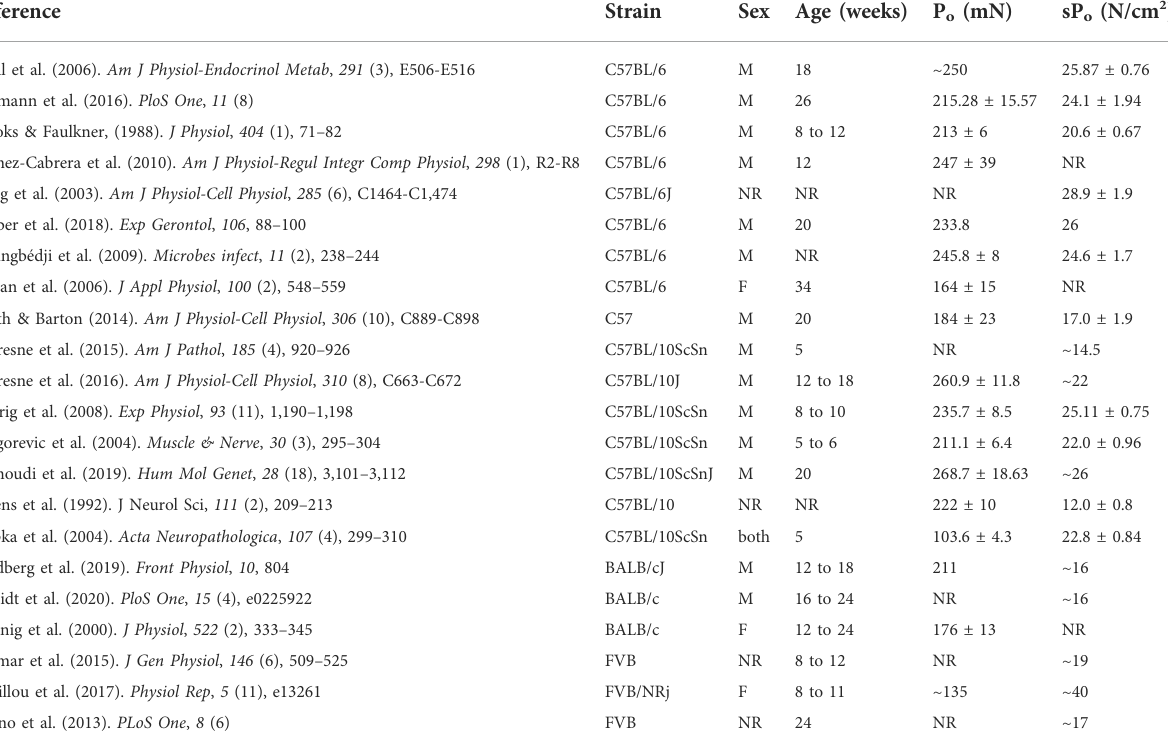
TABLE2Reportedvaluesofabsolute(P o )andspeci fi c(sP o )forceproductionfromthesoleusmuscleofBL6,BL10,BALB/c,andFVBstrains(NR=value eitherabsentornotreportedinN/cm 2 ;~=valueestimatedfromarticle fi gures).PubMedandGoogleScholarsearchesincludedmultipledifferent combinations of the following key terms —‘ mouse, ’ ‘ murine, ’ ‘ skeletal muscle, ’ ‘ contraction, ’ ‘ force, ’ ‘ C57BL/6, ’ ‘ C57BL/6J, ’ ‘ C57BL/6NJ, ’ ‘ BALB/cJ, ’ ‘ C57BL/10, ’ ‘ FVB/NJ. ’